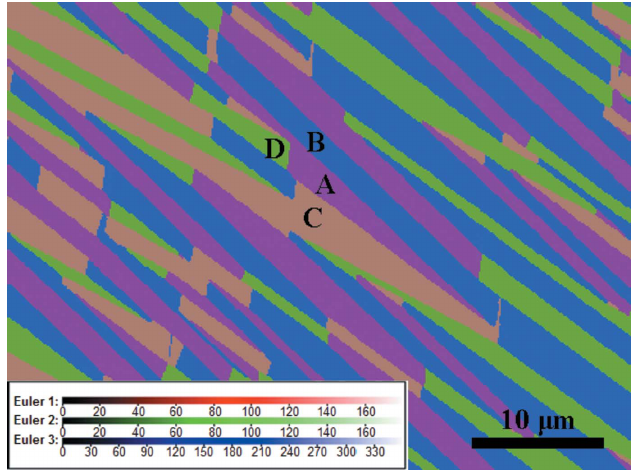
Figure 1 An EBSD ‘all Euler’ orientation micrograph of 7M martensite with four variants (A, B, C and D) in one variant colony in an Ni 50 Mn 30 Ga 20 alloy. The inset shows the legends of the Euler